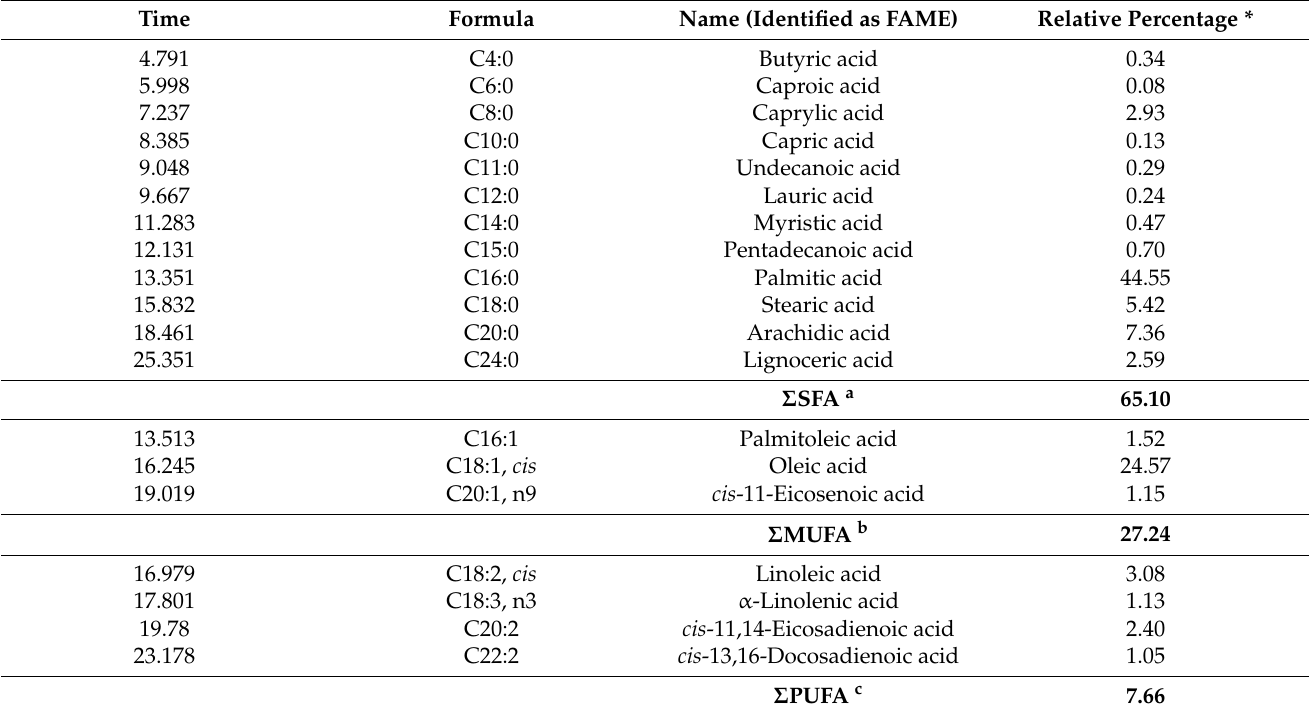
Figure 1. GC-FID analysis of Jordanian propolis sample, showing different identified FAME. Table 1. Fatty acid composition of propolis.